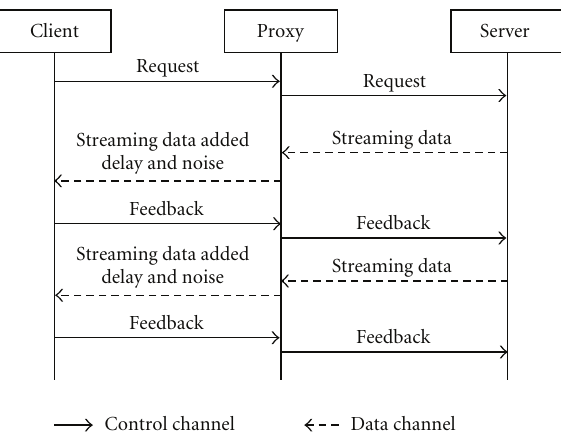
Figure 1: Sequence diagram of the server-proxy-client model.